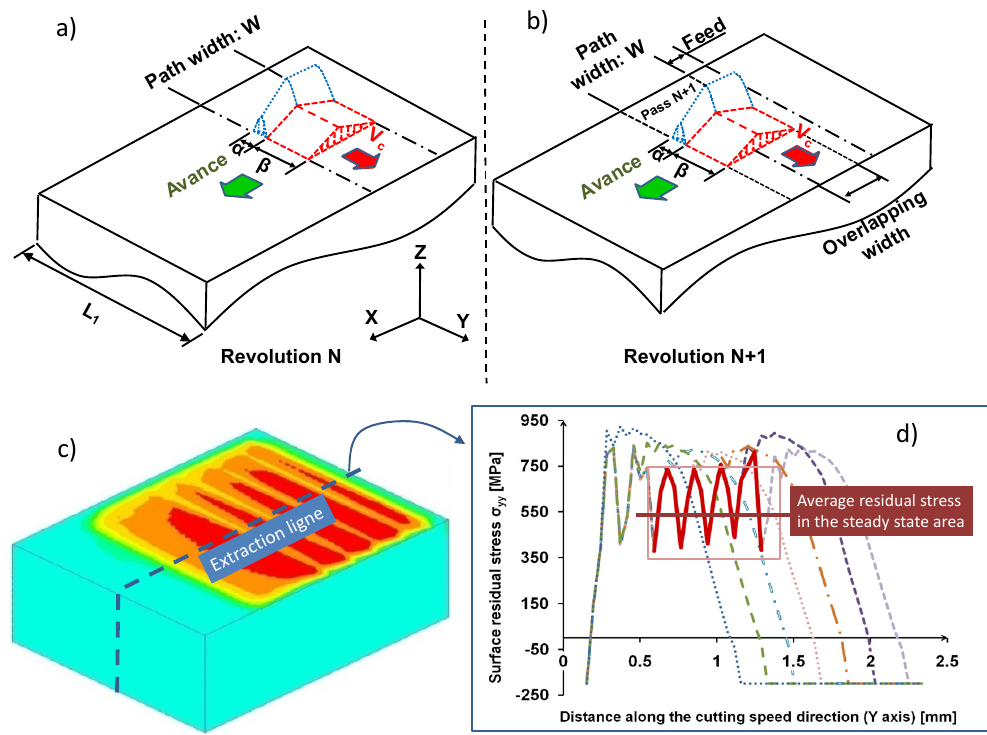
Figure 7. Movement of the thermomechanical loadings during revolution N ( a ) and N + 1 ( b ) Example of extraction of the residual stress profile ( c ) Average value of the residual stress in the steady-state area ( d ) Evolution of residual stress along the axis